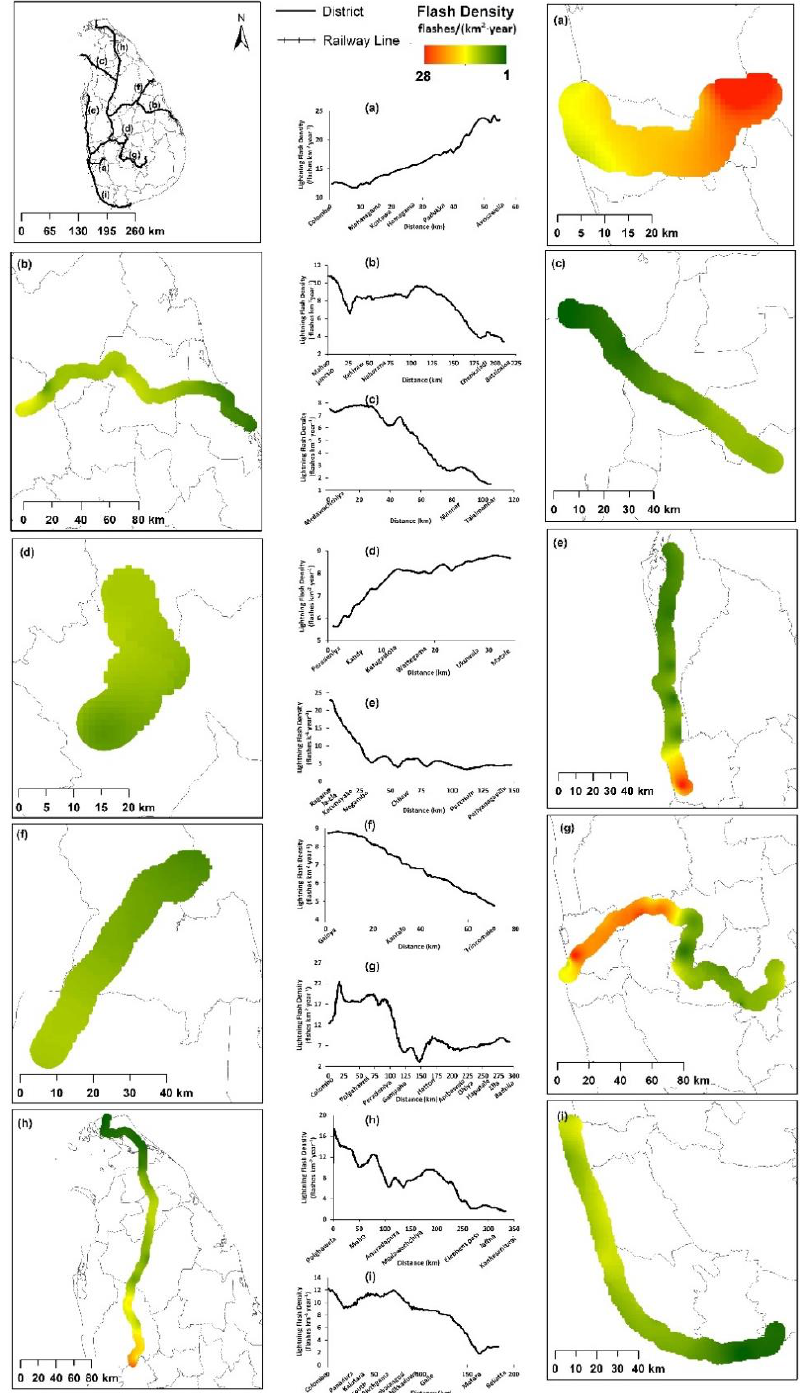
Figure 3. Spatial variability of the lightning flash density over the existed railway lines and distribution of lightning flash density along the railway line at each point of 1 km distance in the period from 1998 to 2014 ( a ) Kelani Valley line ( b ) Batticaloa line ( c ) Mannar line ( d ) Matale line ( e ) Puttalam line ( f ) Trincomalee line ( g ) Mainline ( h ) Northern line ( i ) Coastal line.